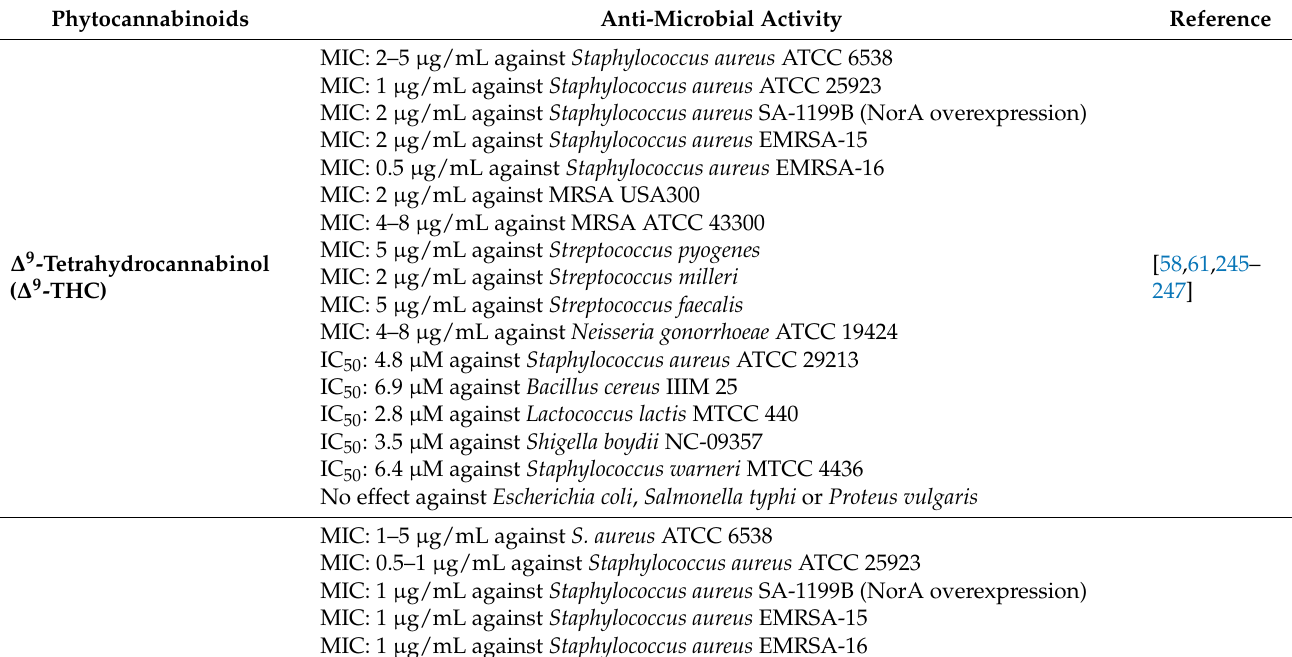
Table 1. Examples of Cannabis sativa constituents that have been documented to possess anti-bacterial, anti-fungal, and/or anti-protozoal activities